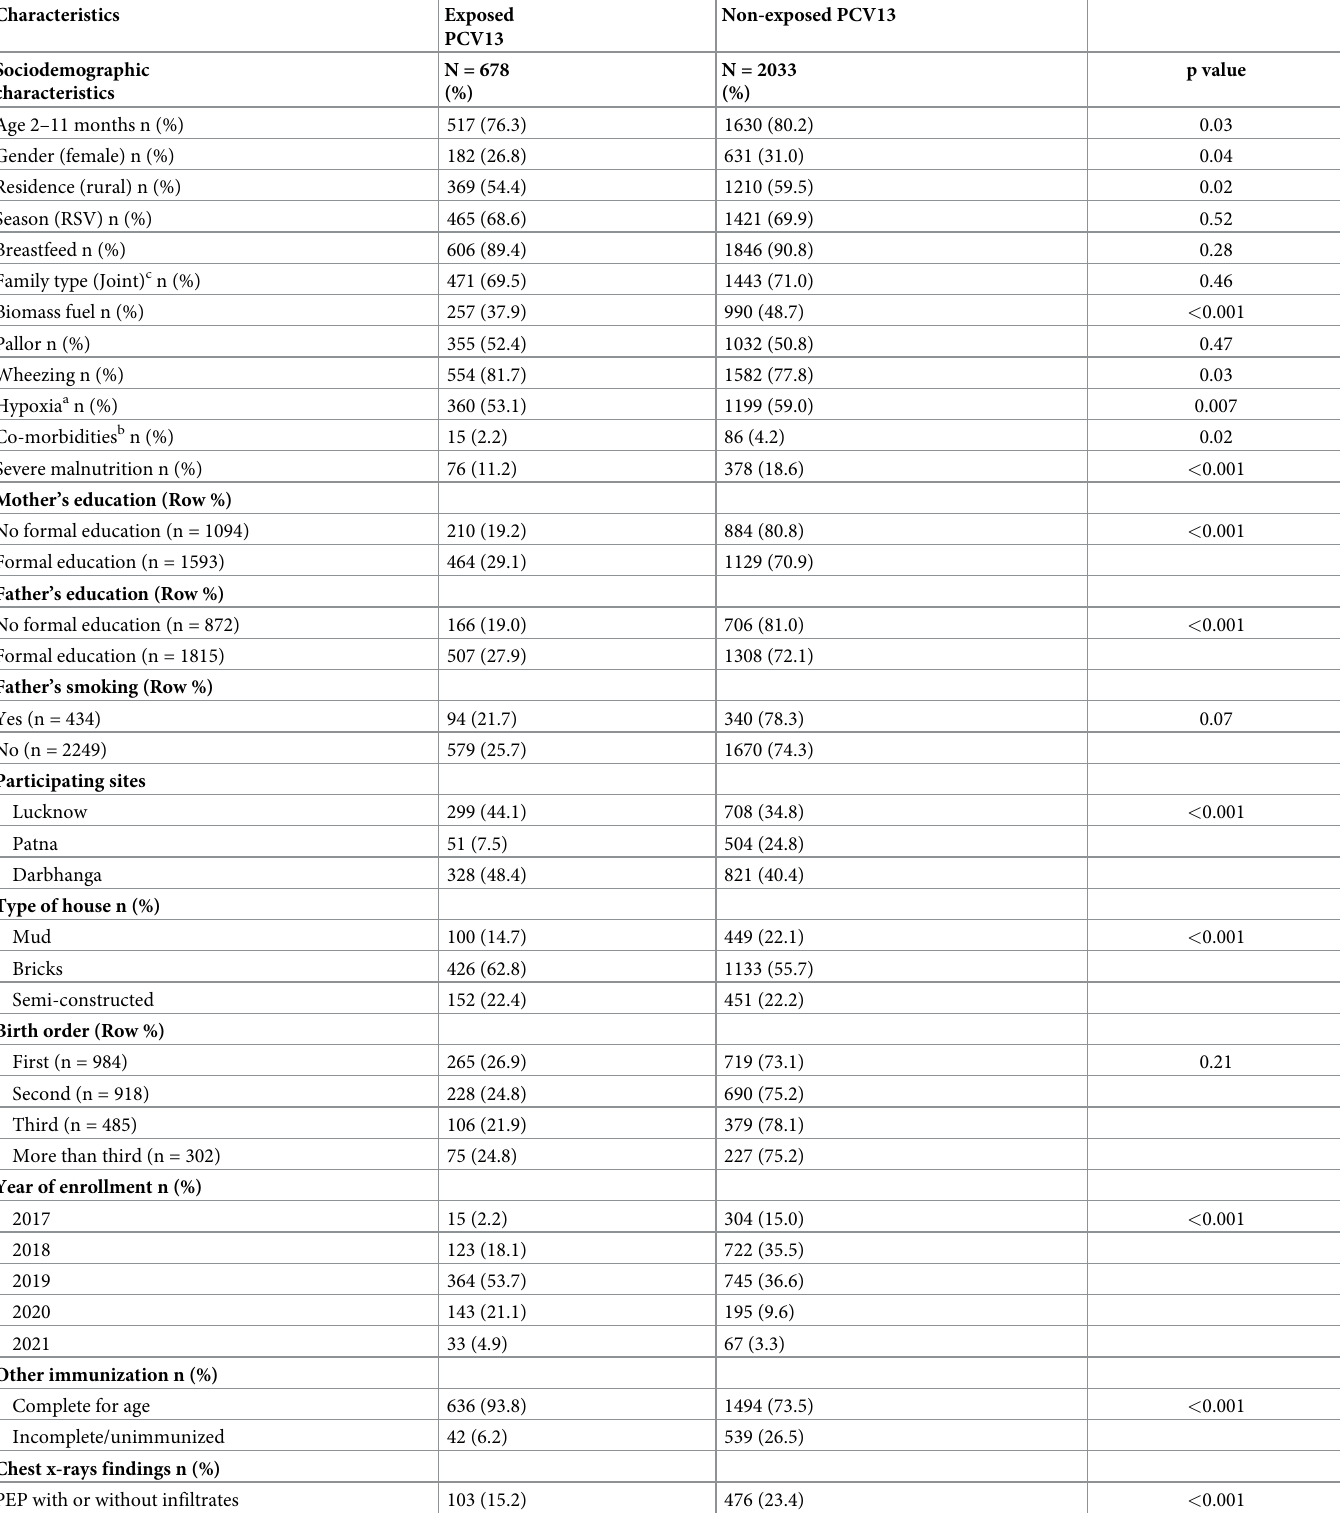
Table 2. Comparison of sociodemographic and clinical variables among the children exposed or unexposed to PCV13 vaccination.